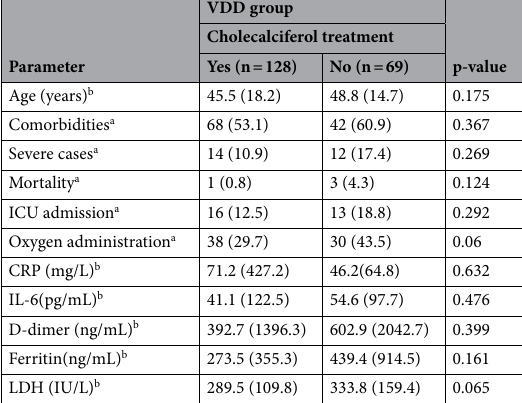
Table 5. Outcomes of cholecalciferol treatment in hospitalized COVID-19 patients with VDD, data presented as number (percentage) for categorical a and mean (SD) for continuous variables b